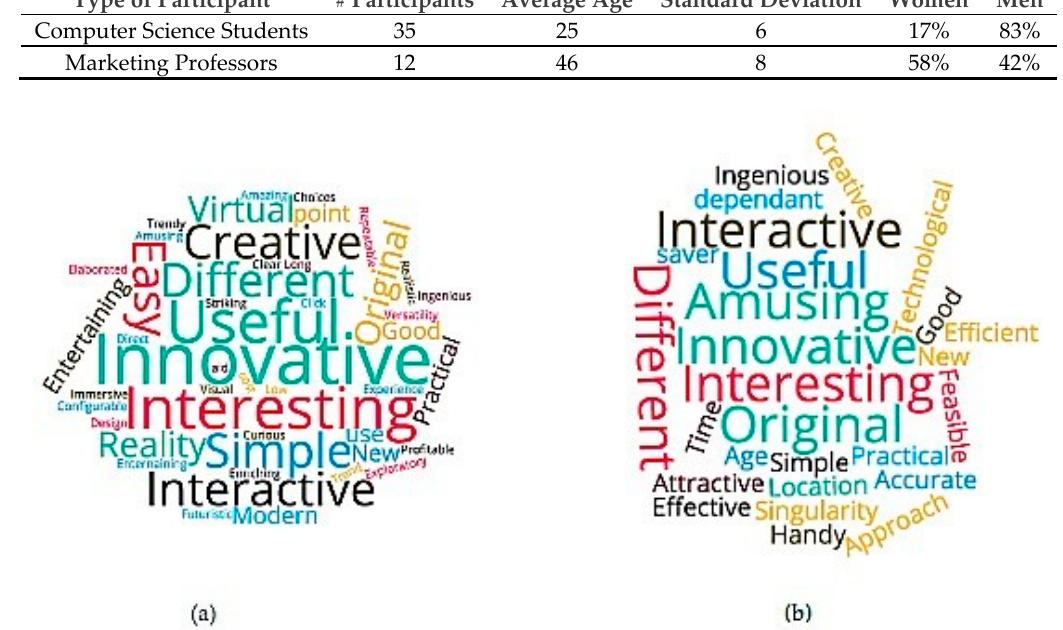
Figure 4. Word cloud created with the characterization given by participants in the idea’s evaluation. ( a ) Computer Science Graduate Students word cloud; ( b ) Marketing professors word cloud.